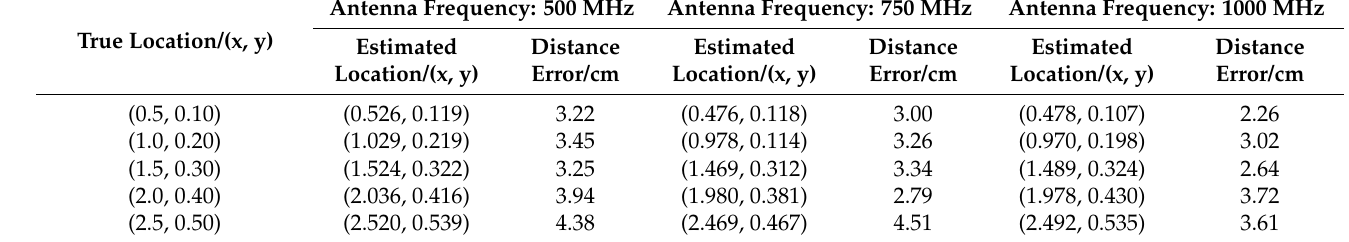
Table 1. Root location results.